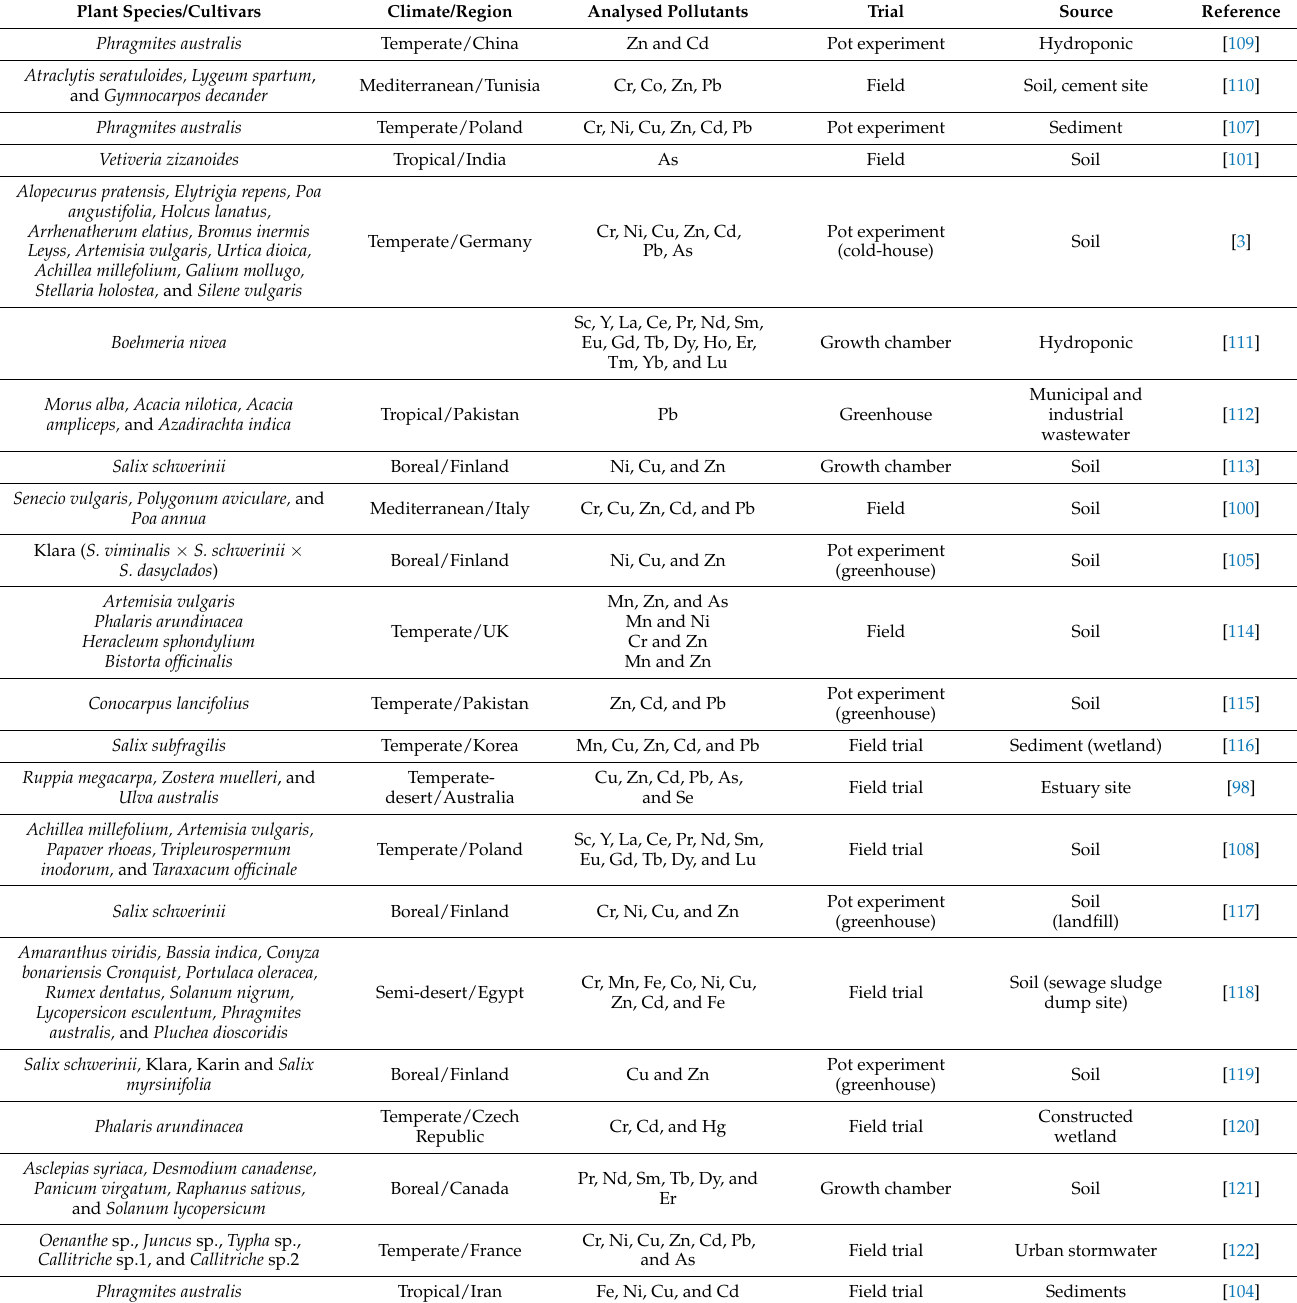
Table 5. A list of plant species tested as candidates for bioindication across the